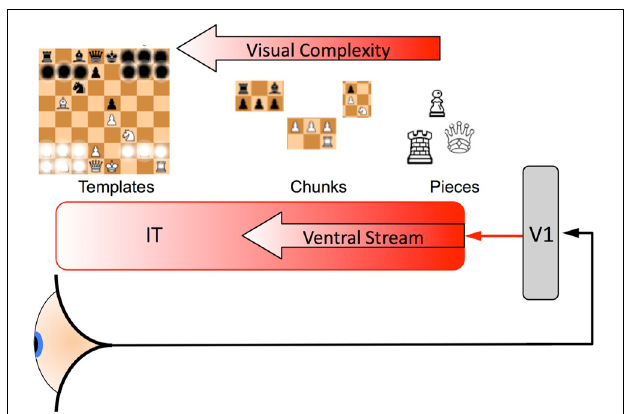
FIGURE 2 | A representation of the category formation mechanism. Information arrives at the eye and passes to the anterior regions of the brain where these signals arrive at V1 (an early visual processing region of the cortex). These signals then pass along the ventral stream of the inferotemporal cortex (IT). Most people from a western country are likely to be able to recognize a single chess piece, more experienced players develop “Chunks” that are aggregates of games pieces as well as schematics for the whole board that include key pieces and their spatial relationships, these “Templates” enable the rapid comprehension of the current state of the game and provide “slots” into which the smaller chunks can be fitted [see for example Gobet et al. (2001) and Gobet and Lane (2010) who have modeled unsupervised template learning in their CHREST model and suggested a neural model for it (Chassy and Gobet, 2011), as does the perceptual templates in Harré (2013) and Harré and Snyder (2012)]. Some of the information (individual pieces) are shown obscured in the Template (far left), only information which is necessary to distinguish one category from the many other possibilities is needed, such game pieces need to have frequently co-occurred in the same places over and over again through a player’s training and experience of the game. In this diagram only one template is shown, however, an expert will have encoded thousands of such templates in their IT and each one “competes” to be recognized: signals that originate from earlier neurons encode simpler representations (a line detected by V1 is simpler than a game piece, a game piece is simpler than a chunk and a chunk is simpler than a template) that combine to make larger and more complex representations of the game, eventually signaling the most complex learned representation such as a template. The neuron that accumulates enough (typically noisy) information to cross that neuron’s threshold is the winner [see the race model, Equations (2) and (3) ] i.e., for two categories the competition would be between neurons C 1 and C 2 in Figure 3 and the thresholds would be Z 1 and Z 2 in Figure 1